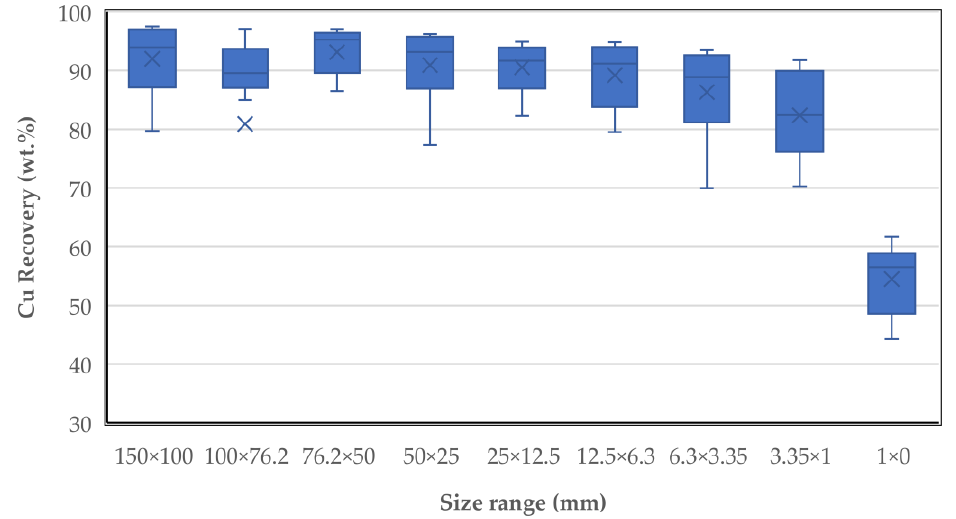
Figure 13. Box plot of copper recovery in rougher flotation for the different size fractions for all stockpiled samples.